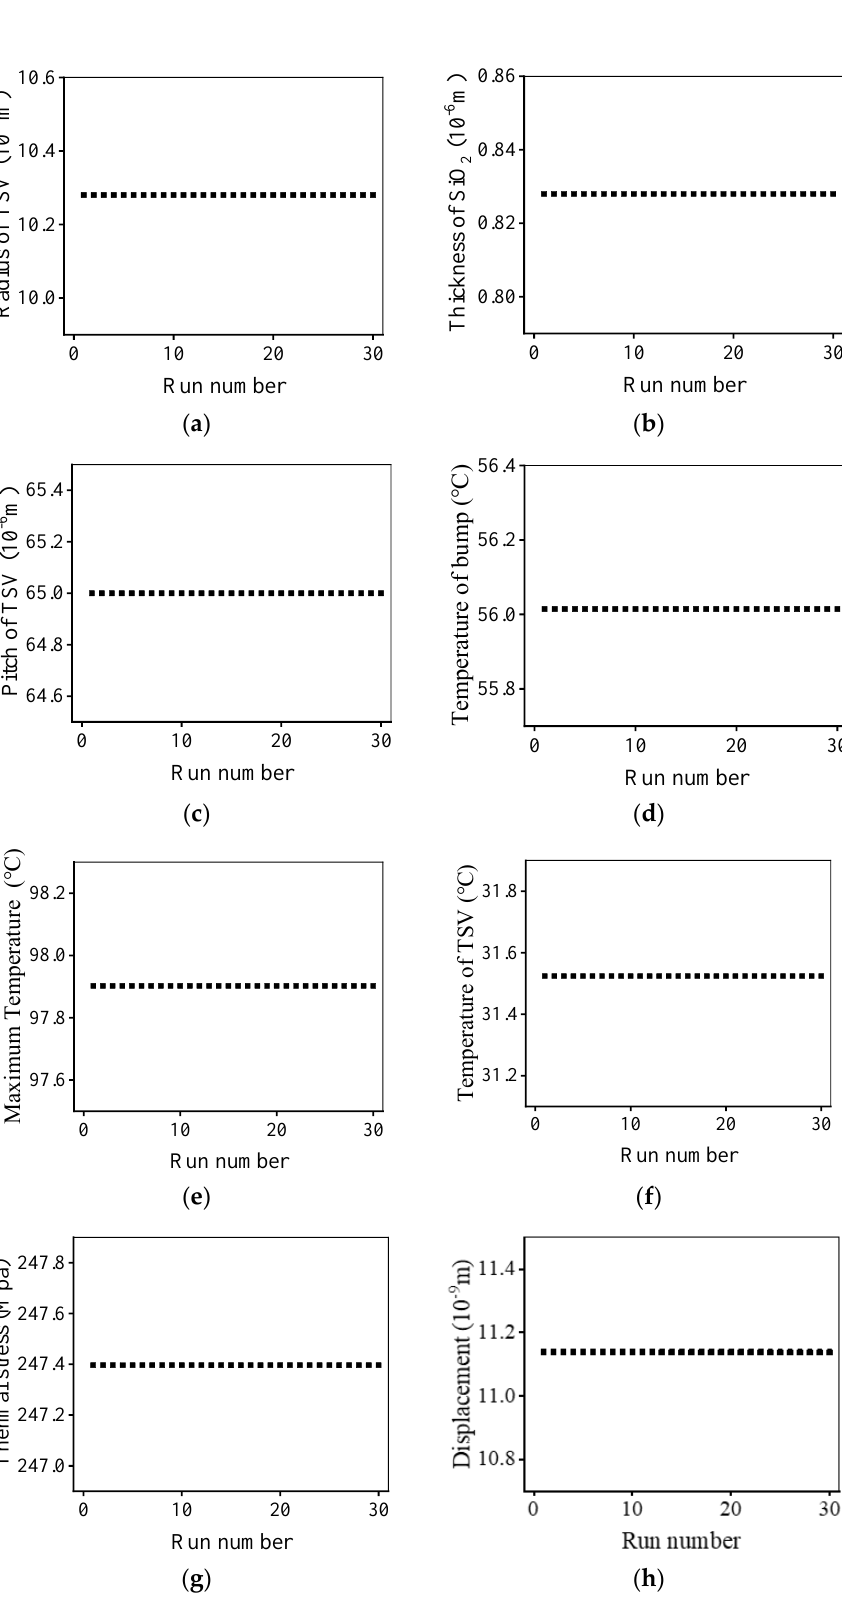
Figure 8. Optimization results: ( a − c ) design parameters; ( d − h ) optimized goal.